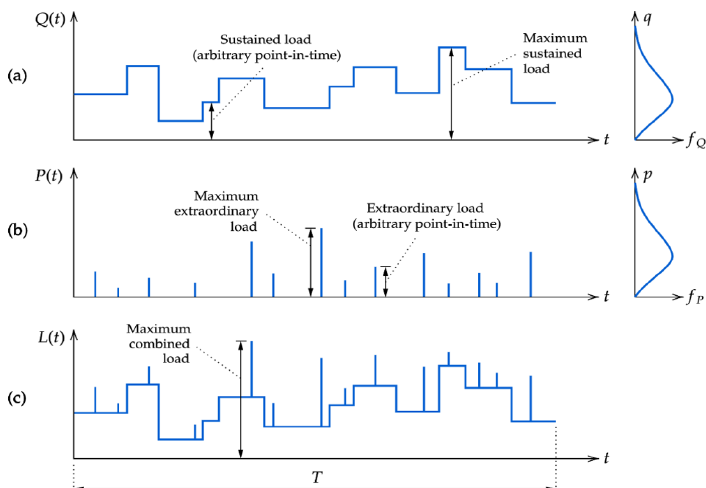
Figure 1. Time histories of live loads: (a) sustained load; (b) extraordinary load; (c) total live